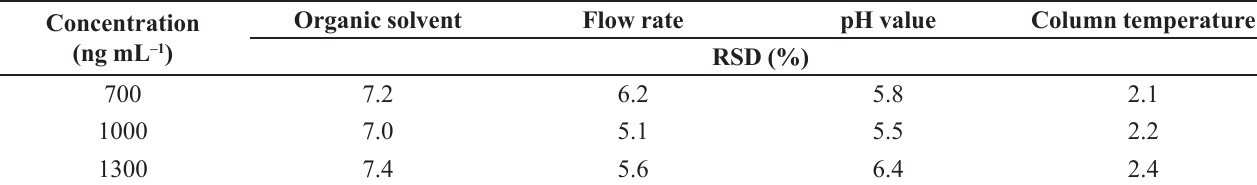
TABLE III - Robustness of the method Concentration